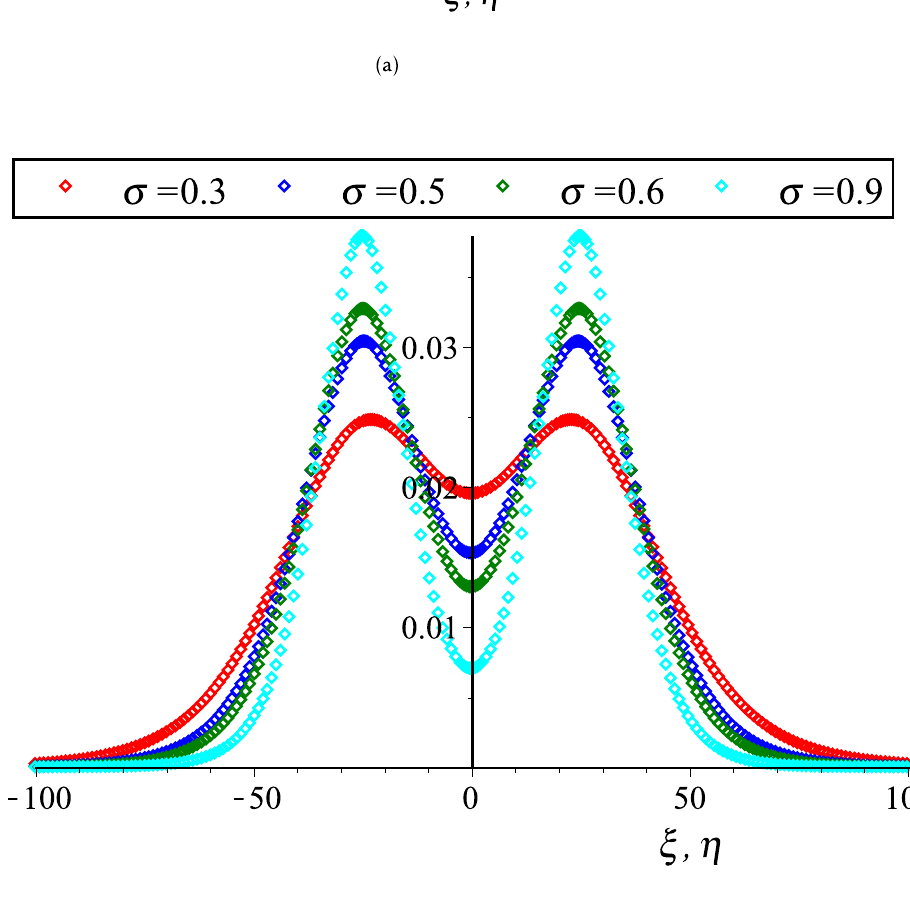
for different values of ( a ) N ec ( σ = 0.5) and ( b ) σ ( N ec = 0.5). (cid:30)